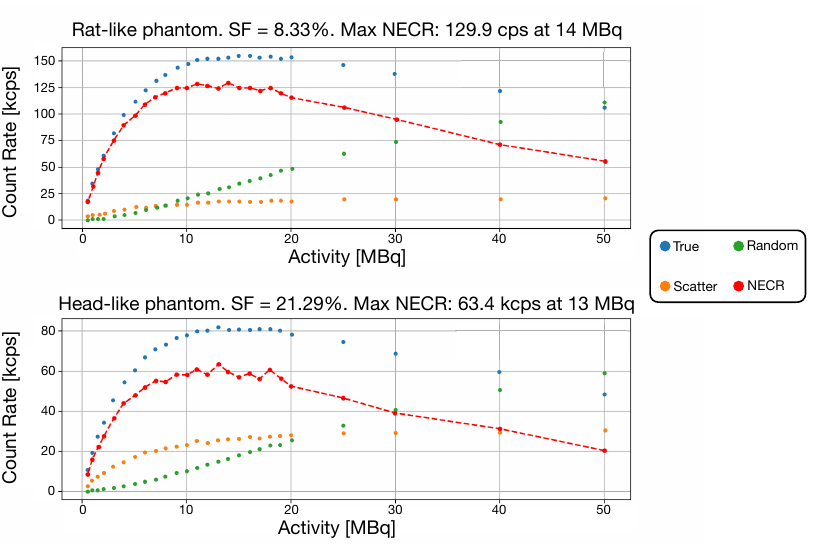
Figure 7. In both images, the NECR data, true, scatter and random events are reported. A red-dashed line is traced between NECR points. ( Top ) NECR for the rat-like phantom. ( Bottom ) NECR for the head-like